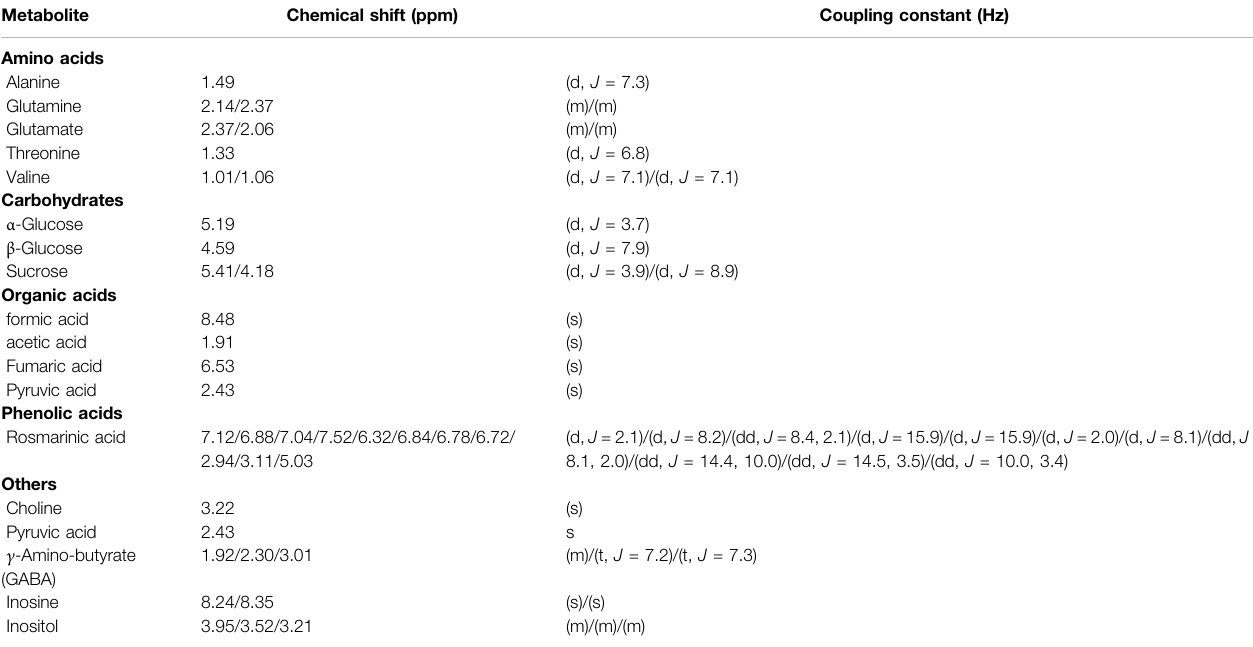
TABLE 1| Chemical shifts ( δ ) and coupling constants( J ) of themetabolites, identi fi ed in Lavandula angustifolia extract by their relevant 1 H NMRspectra (Pereira et al., 2013; Georgiev et al., 2015; Marchev et al., 2017). Metabolite Chemical shift